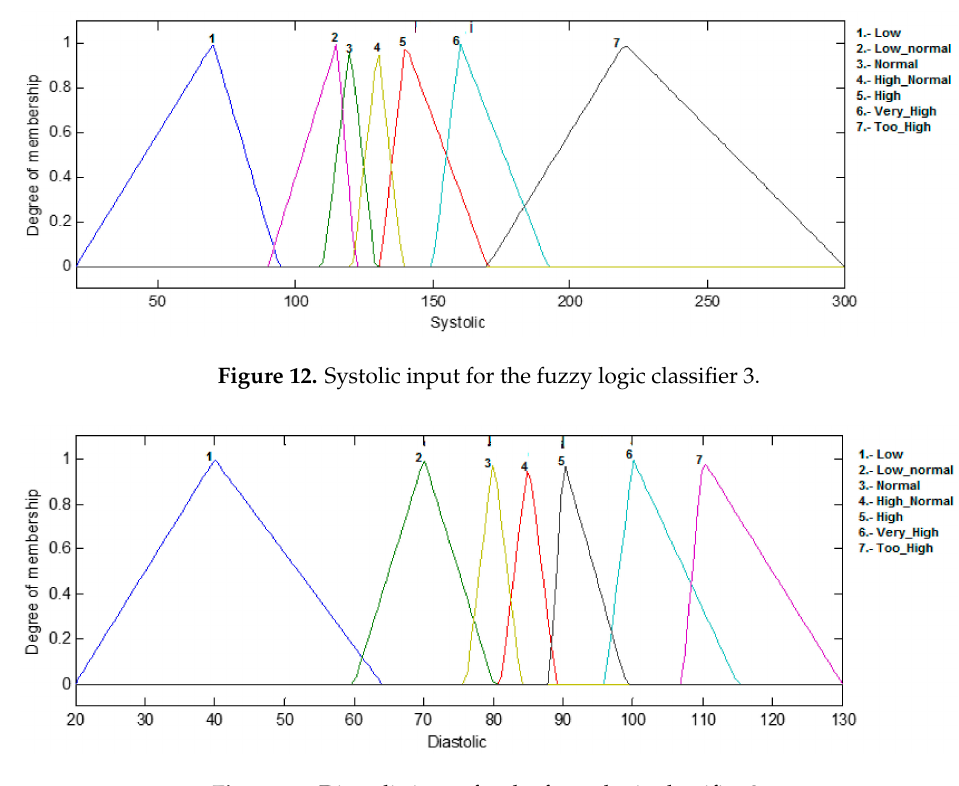
Figure 13. Diastolic input for the fuzzy logic classifier 3.